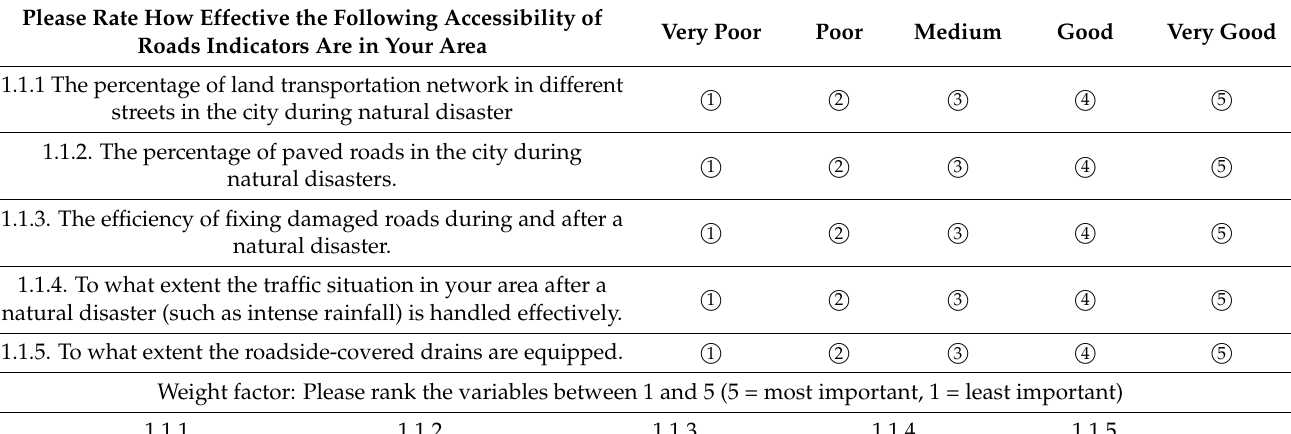
Table 2. A sample of the Climate Disaster Resilience Index (CDRI) questionnaire